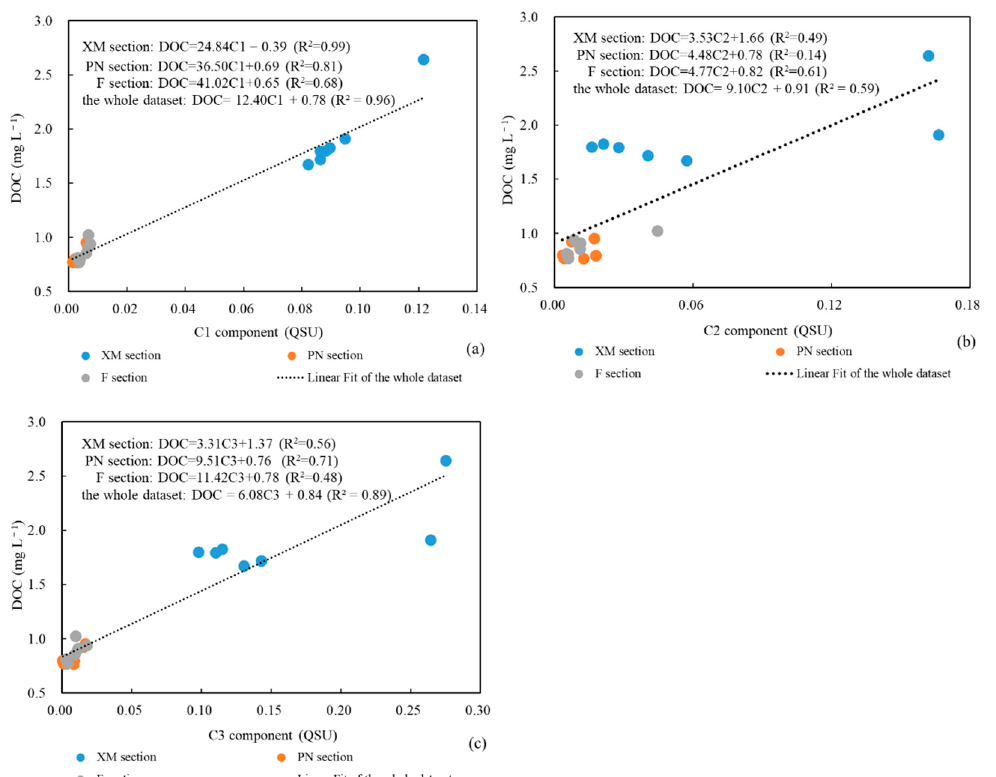
Figure 12. Correlations between the dissolved organic carbon (DOC) and the chromophoric dissolved organic matter (CDOM) fluorescence intensities of the components: ( a ) C1 versus DOC; ( b ) C2 versus DOC; and ( c ) C3 versus DOC. The correlations between the DOC and the fluorescence intensities of the three fluorophores in the three different sections differ.